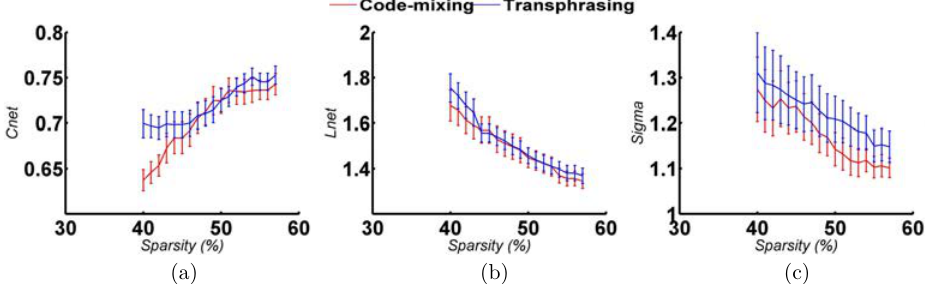
Fig. 9. Comparison of the small-world indicators between the code-mixing and transphrasing translation strategy with relative thresholding: (a) the clustering coe±cient, (b) average path length and (c) measure of small-worldness. The curves ð mean (cid:3) SE Þ show the network indicators with di®erent sparsity, in which the red and blue color represent the code-mixing and transphrasing strategy respectively. The horizontal axes denote the sparsity values whereas the vertical axes denote the network property